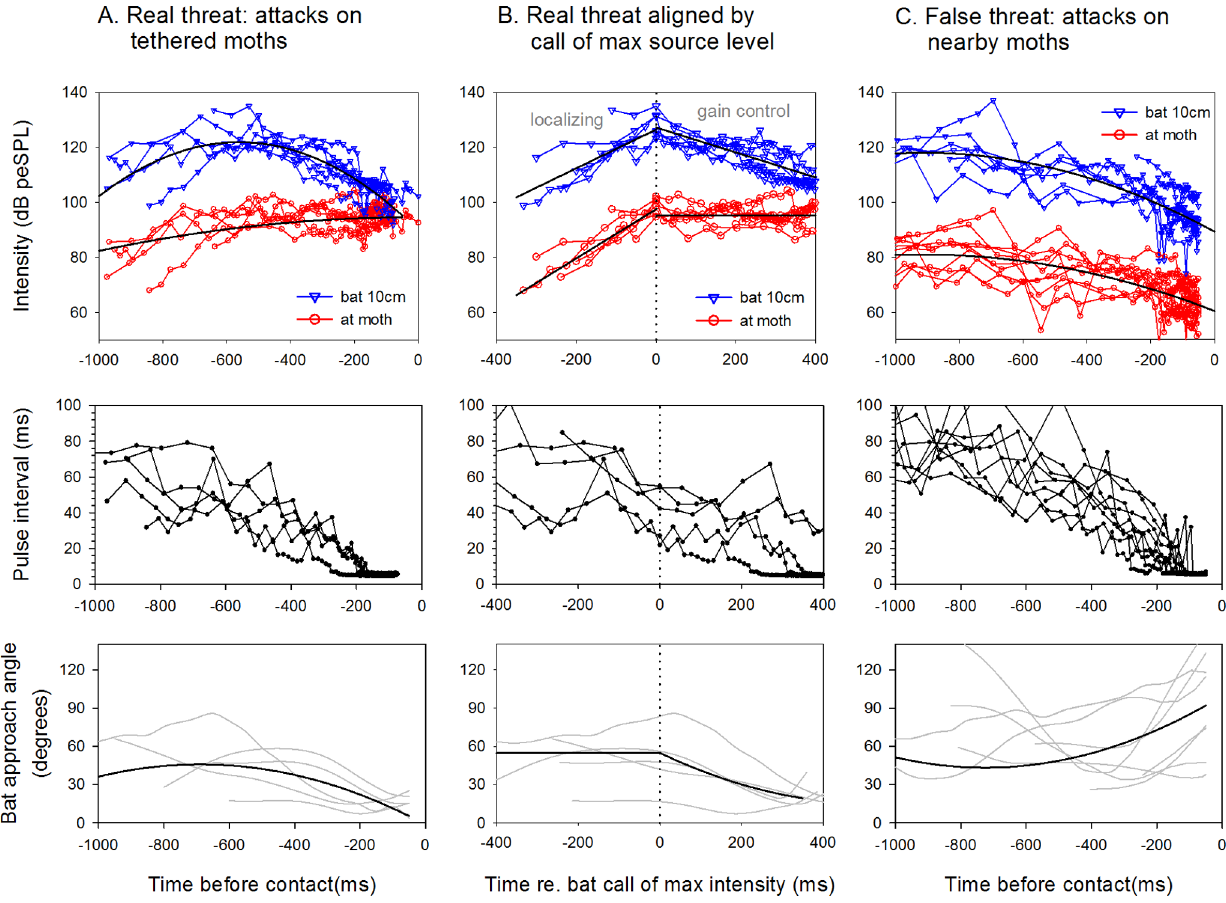
Figure 5. Characterization of ‘‘real’’ and ‘‘false’’ threats. A real threat is a bat attacking the target moth (A, B); a false threat is a bat attacking a nearby moth (C). Real threats are shown (A) aligned by the end of the attack, and (B) aligned by the echolocation call of maximum intensity. The top panels show the bat echolocation intensities 10 cm from the bat (emitted in the moth’s direction) and at the moth’s position. Middle and bottom panels show how bat pulse intervals and approach angles change over the course of an attack, respectively. The rise in bat call intensity early in attacks in A and B reflects the bat localizing the moth, followed by an immediate decrease in emission intensity, which contributes to the bat’s automatic gain control (see text and Figure 2) [21]. Bats engage gain control (time=0 s in B) in the middle of approach phase and then soon turn towards the prey (a decrease in approach angle). False threats are characterized by decreasing call intensities at the moth’s position and approach angles that are poorly correlated with time in the attack (see Table 1 for